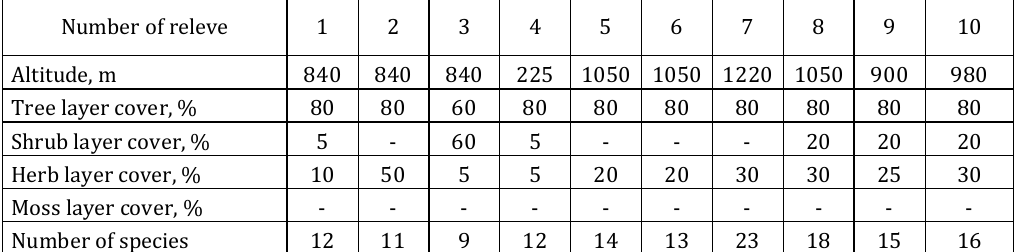
Table 1. Syntaxonomical characteristics of the association Symphyto cordati-Fagetum sylvaticae Vida (1959) 1963 (class Сarpino-Fagetea sylvaticae Jakucs ex Passarge 1968)